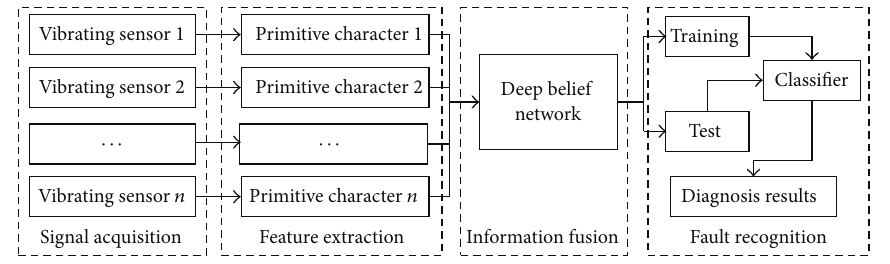
Figure 2: The flow diagram of multisensor information fusion.